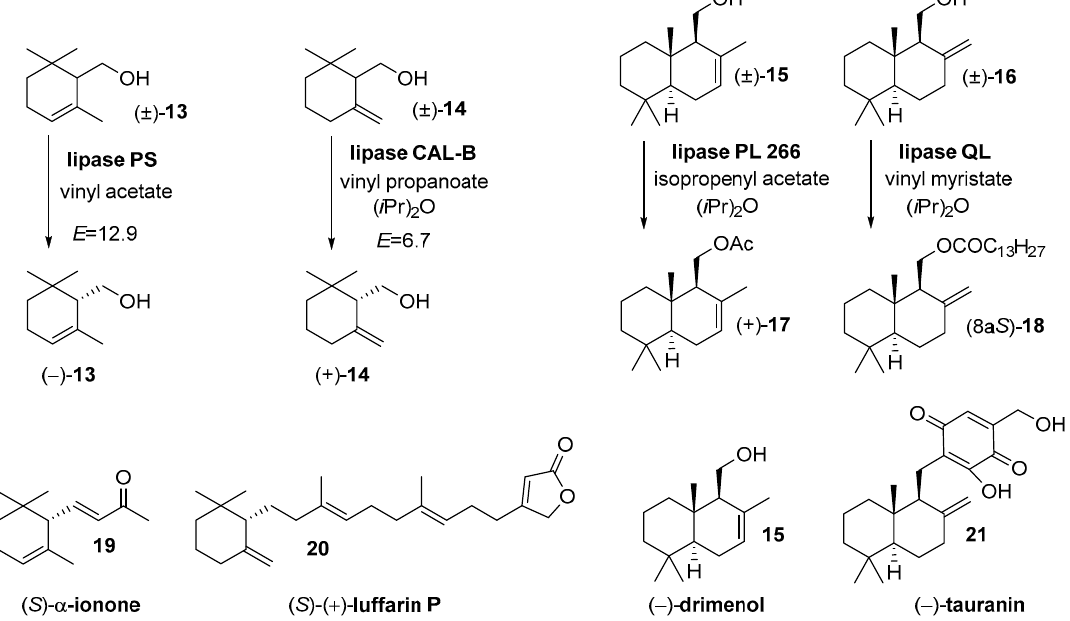
Figure 4. The lipase-mediated resolution of the two couples of substituted cyclohexenylmethanol regioisomers 13 , 14 and 15 , 16 . Compounds 19, 20, ( − )- 15 , and 21 are the natural products synthesized by using the chiral building blocks 13 , 14 , 17 , and 18 , respectively.